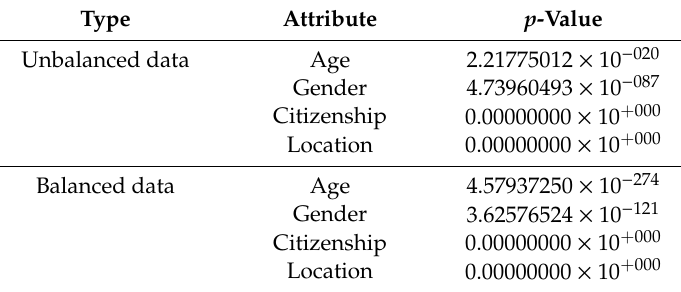
Table 2. Chi-square p -values for di ff erent individual